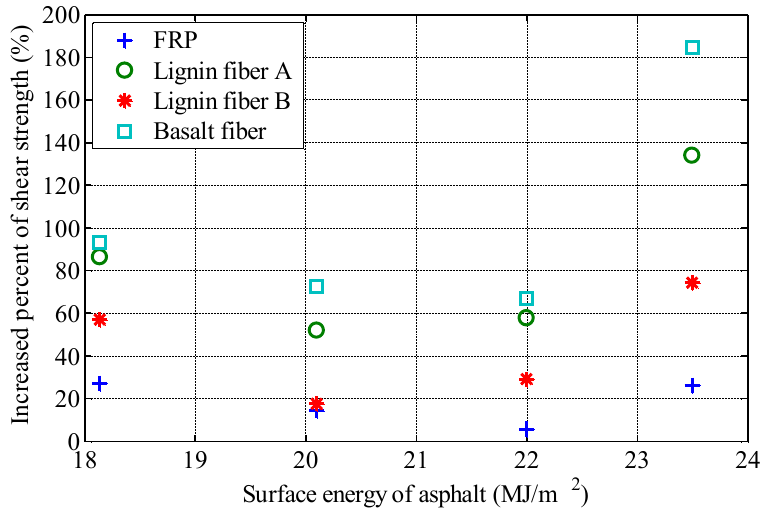
Figure 6. Relationship between surface energy of asphalt and increase percent of shear strength.